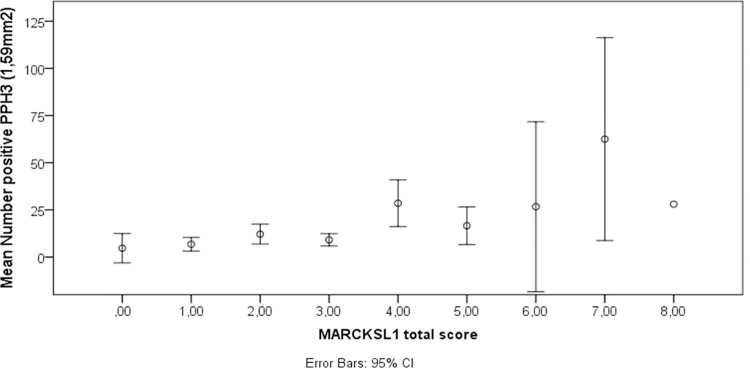
Correlation between MARCKSL1 total score and PPH3 in breast tumors.